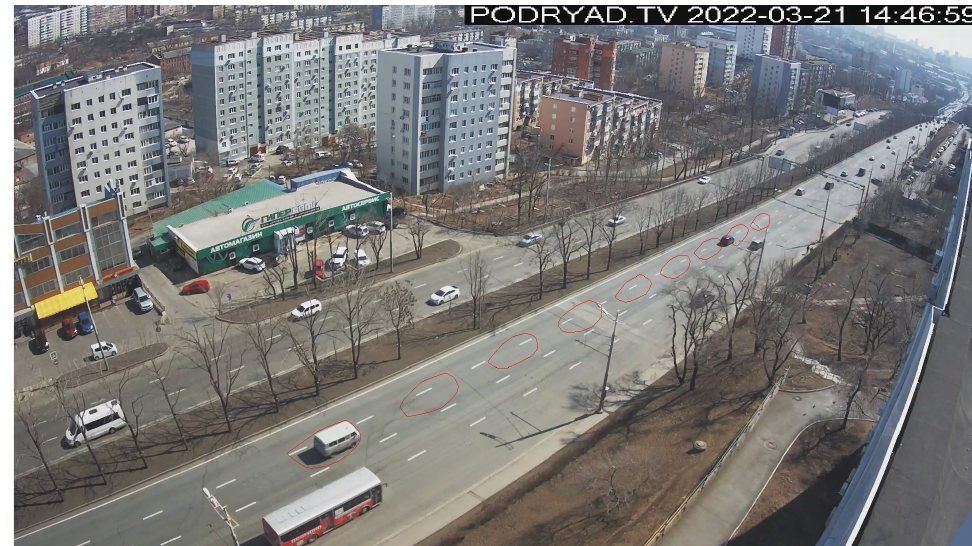
Figure 7. Every twentieth contour of a vehicle’s trajectory in the original image Φ .